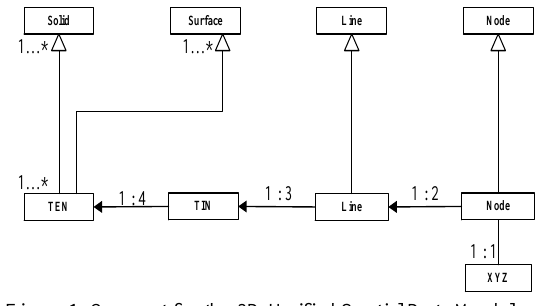
Figure 1. Concept for the 3D Unified Spatial Data Model Nodes are formed by geographic coordinates XYZ which can form point features such as lamp posts, fire hydrant features and are part of the city furniture. Two nodes is part of the line or segment and can be expressed as a beginning node and an ending node. Three of such lines or segments will become